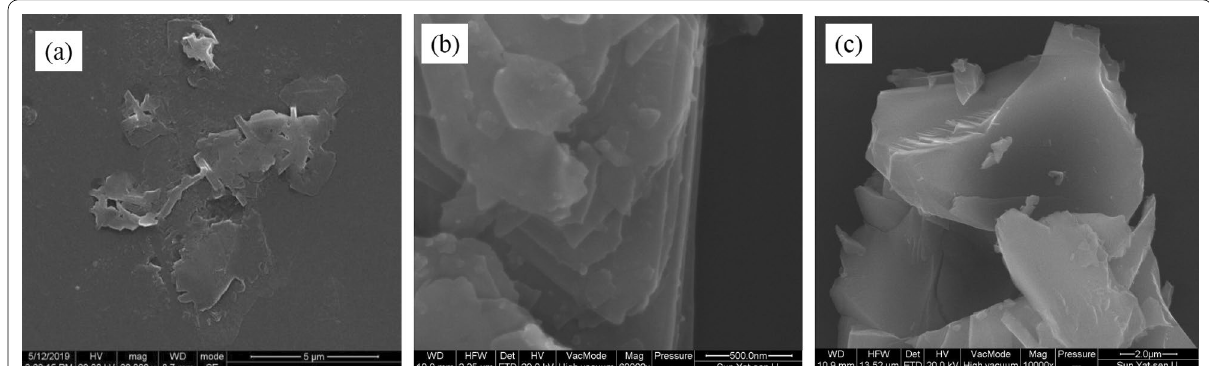
Fig. 6 SEM images of MoS 2 nanosheets prepared with different proportions of MoS2 power and NMP liquid. The volume of NMP is 25 ml, and the masses of MoS